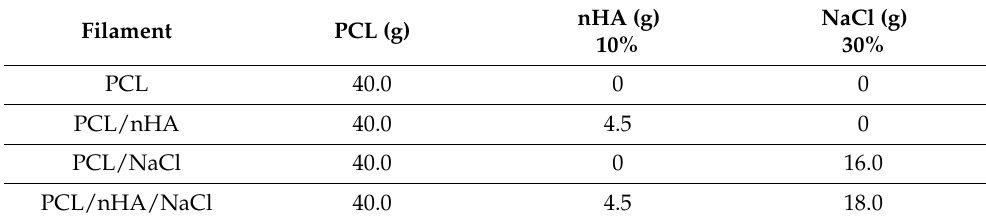
Table 1. Variation of filament manufacturing